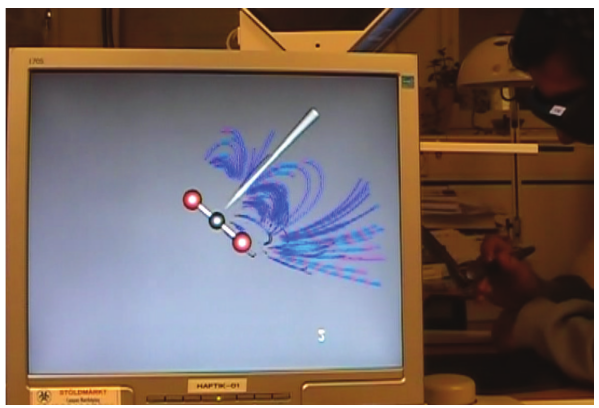
Figure 4: Student S2 uses the haptic device to probe the centre of the carbon atom in CO 2 during interaction with the system. In contrast with the verbal output obtained from S2, the visuohaptic model does not in fact provide any haptic feedback in the region probed by the student in this specific